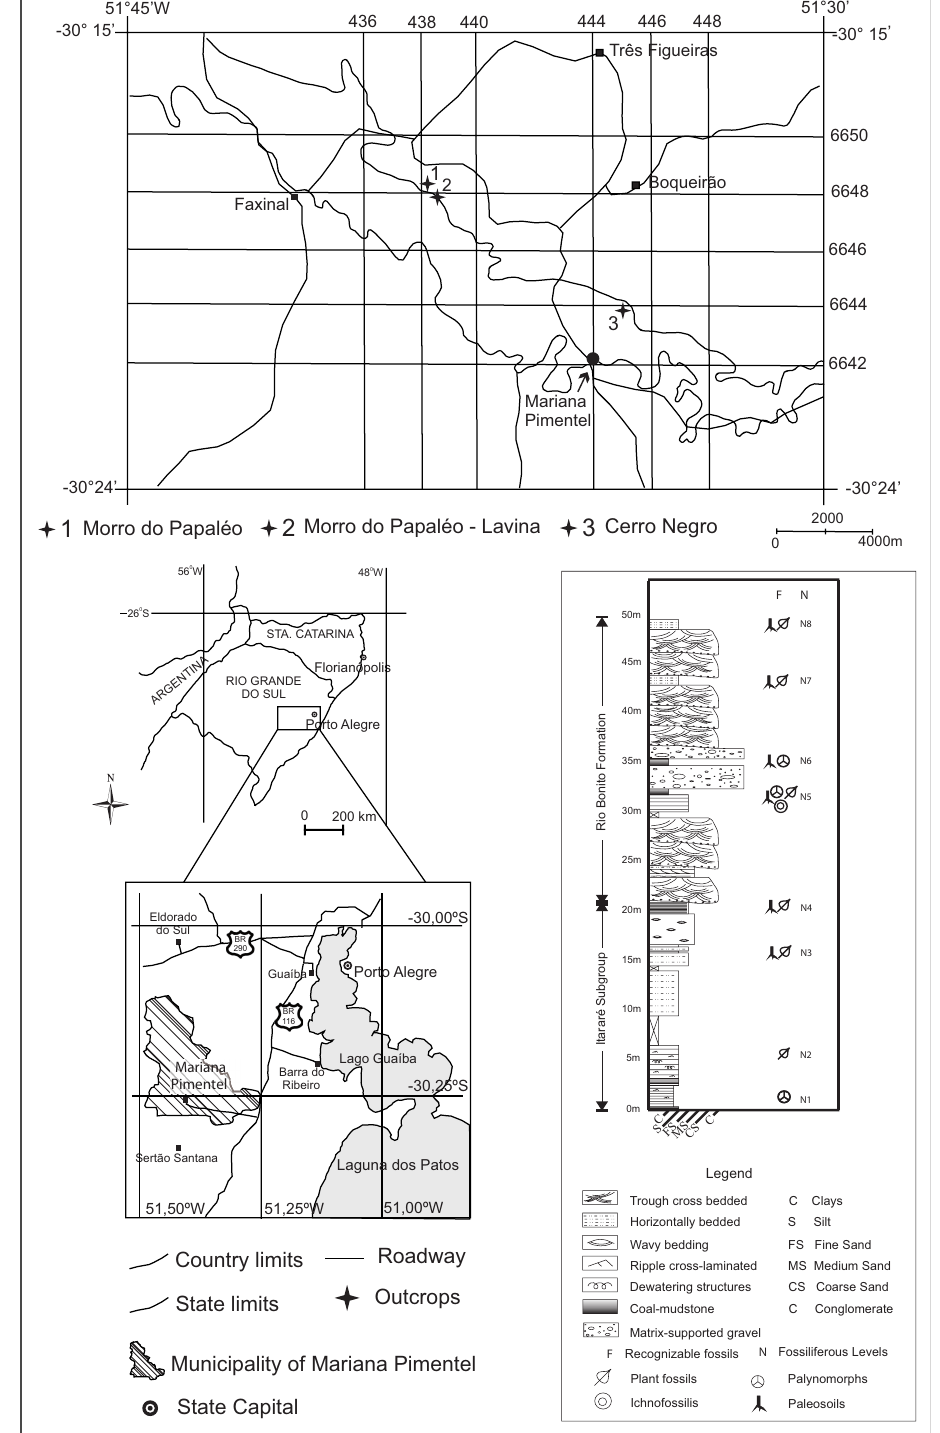
Figure 1: Map of the Mariana Pimentel Municipality in eastern Rio Grande do Sul with the location of the outcrops: 1, Morro do Papaléo; 2, Faxinal Section; 3, Cerro Negro (mod. from Paim et al. 1983, Iannuzzi et al. 2006 and Souza and Iannuzzi 2009). Stratigrafic section of the Morro do Papaléo outcrop showing the plant-bearing levels as described in the text (mod. from Iannuzzi et al. 2007, Souza and Iannuzzi